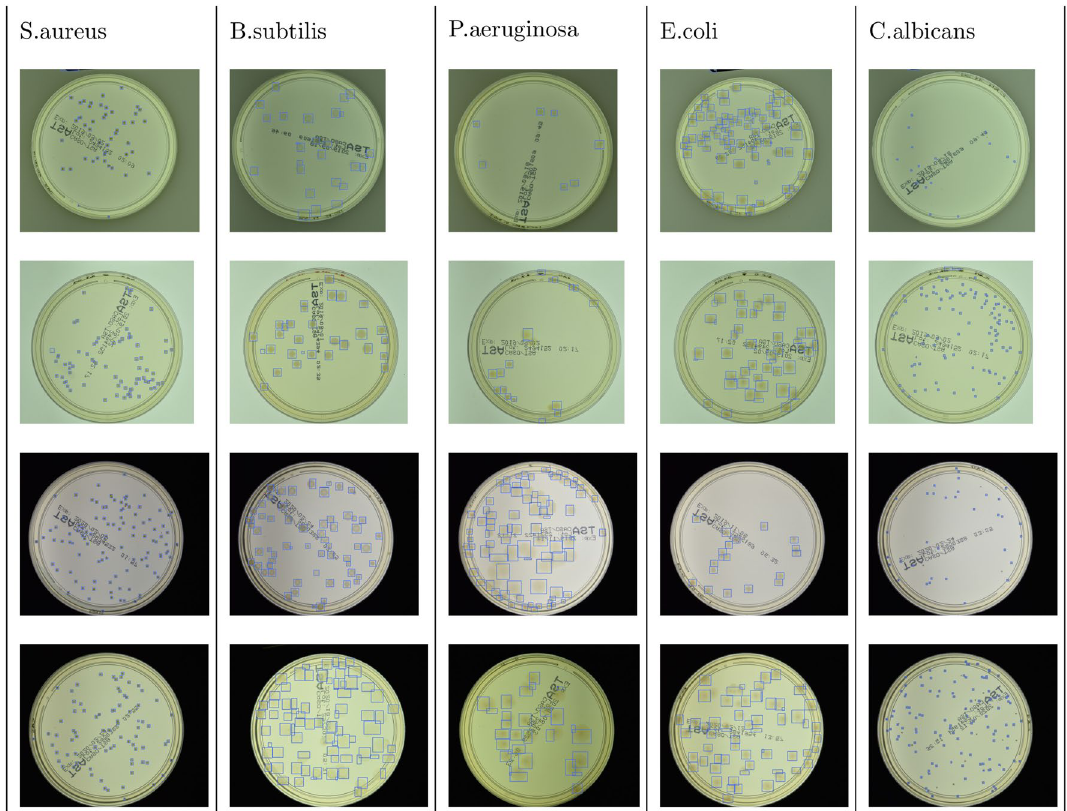
Figure 7. Examples of microbial colonies detection on real data—Petri dishes from AGAR dataset. The Faster R-CNN detector correctly detects the vast majority of colonies, however some missing bounding boxes especially for crowded samples can be